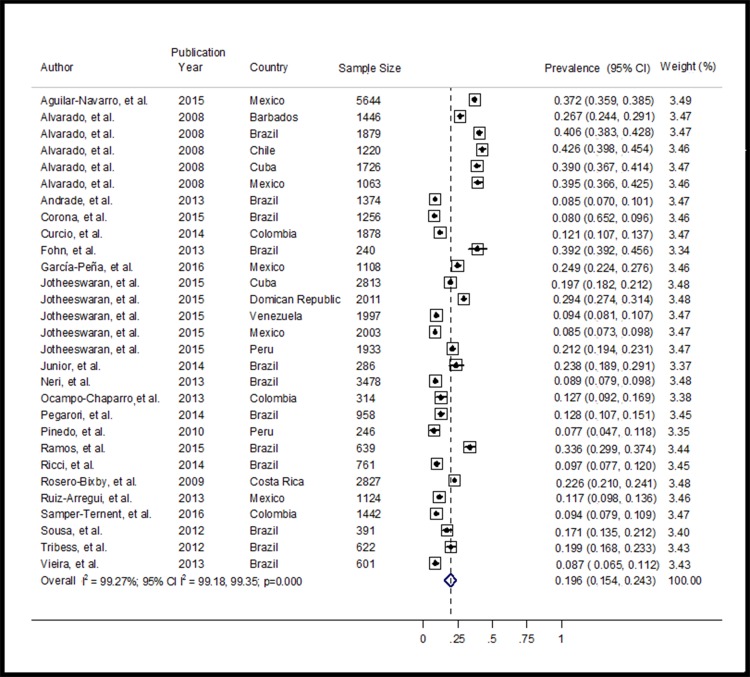
Meta-analysis of the prevalence of frailty in LAC.